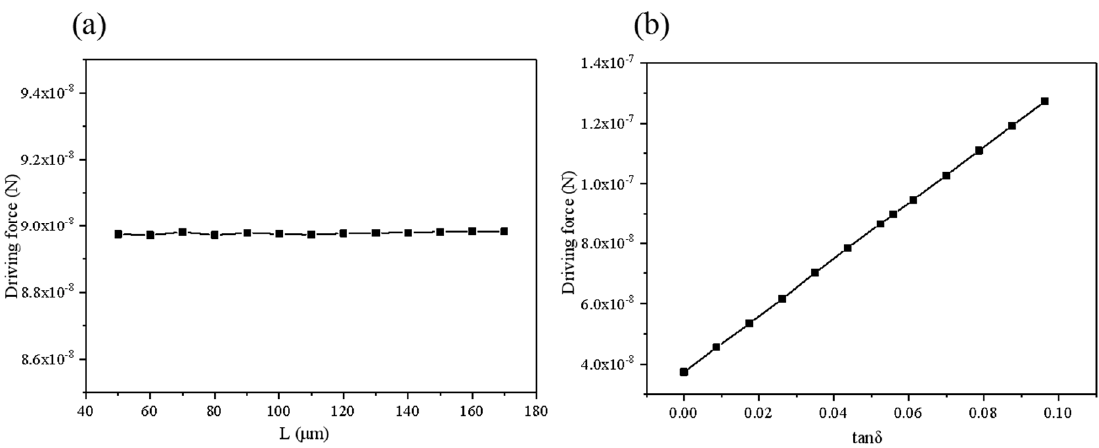
Figure 10. Relationship between driving force and ( a ) micromotor length ( b ) tangent semi-cone angle.